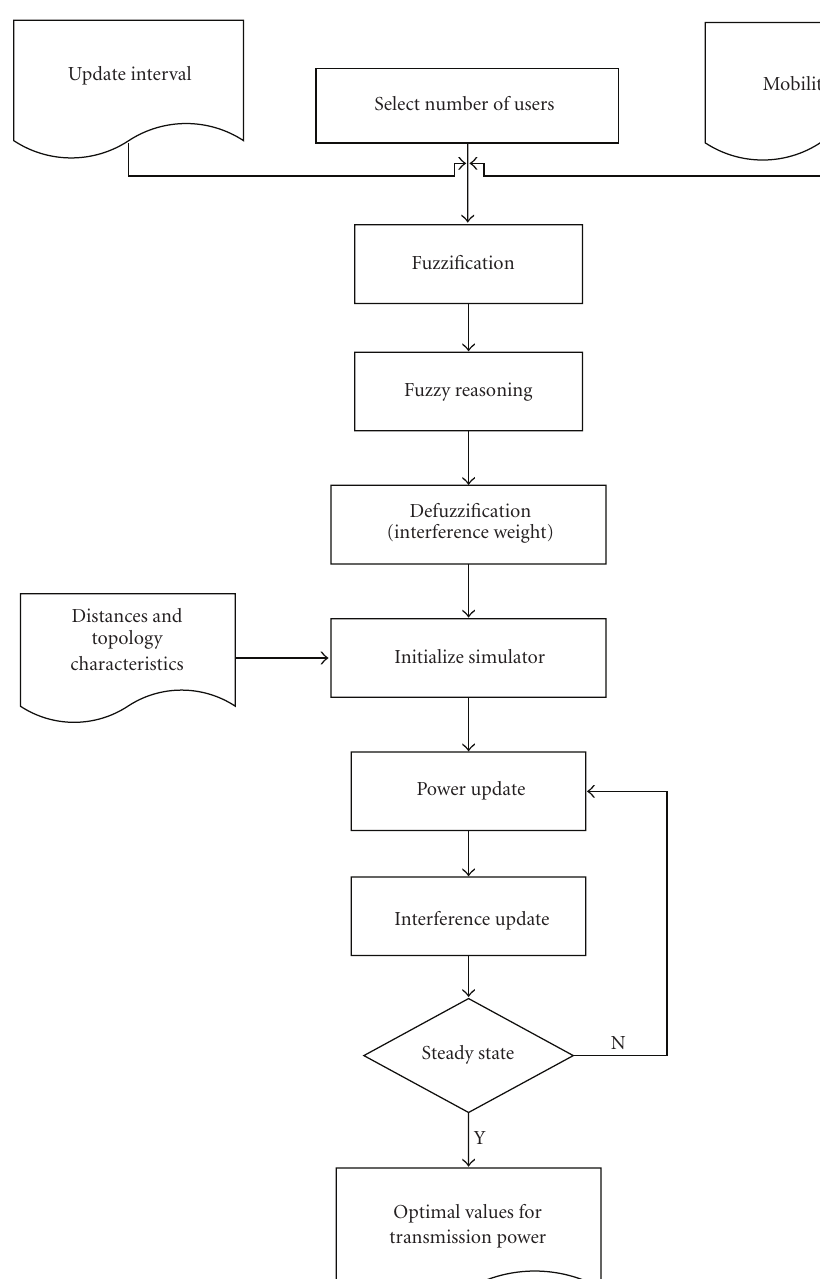
Figure 5: Overall methodology for deriving the transmission power